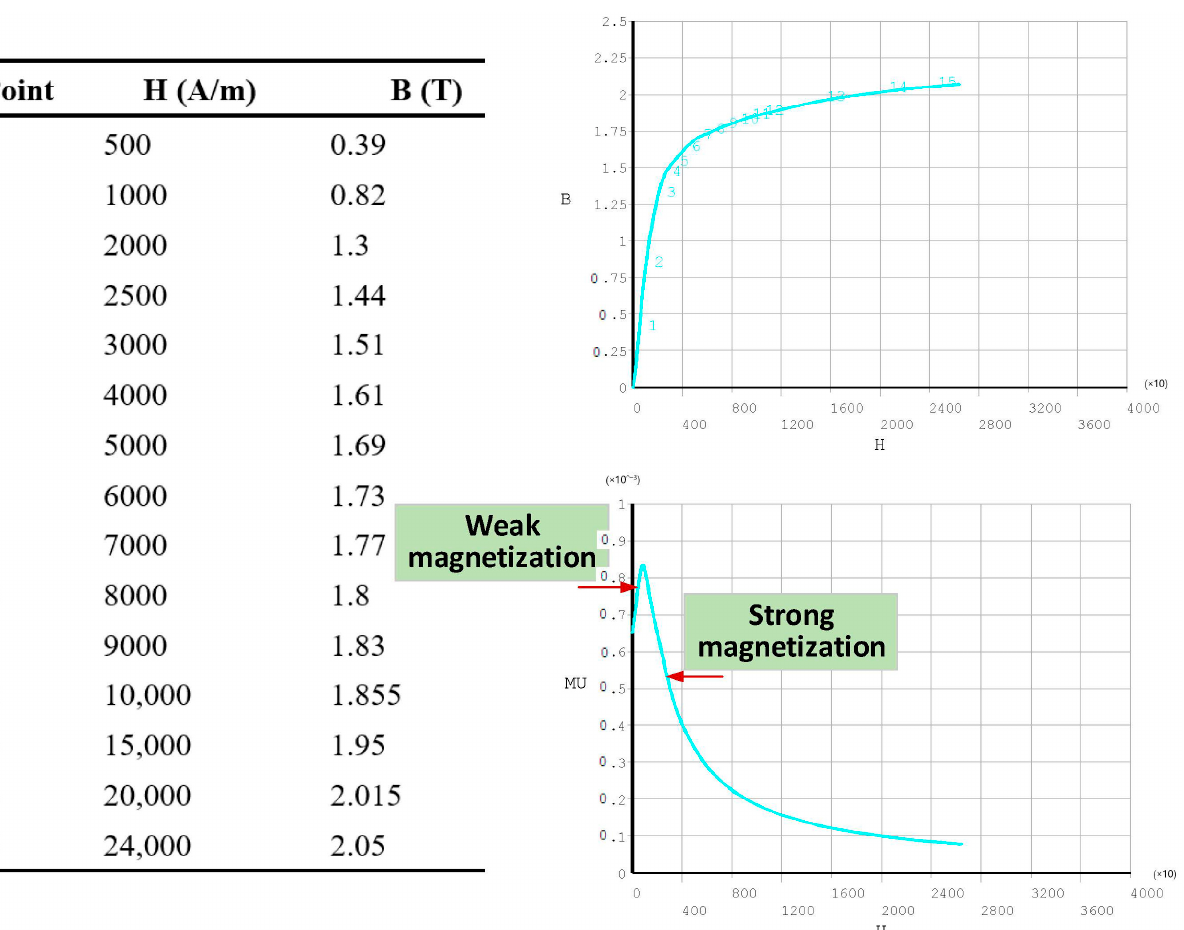
Figure 7. The 2D axisymmetric model.